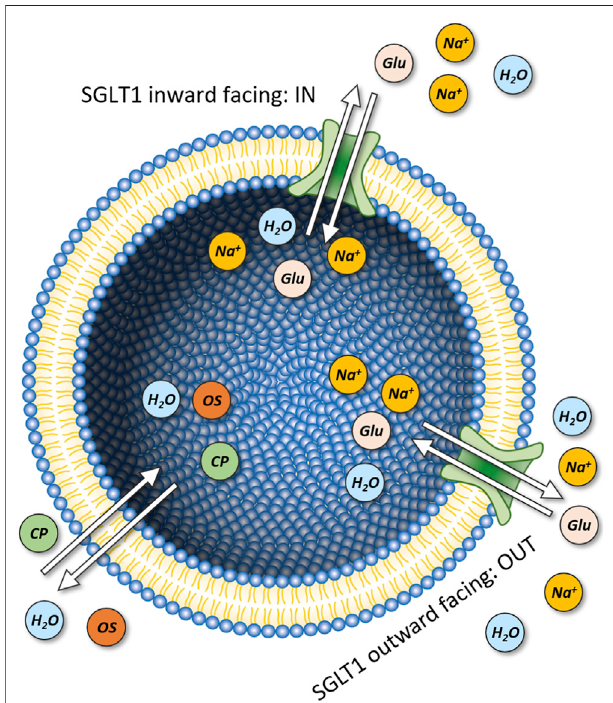
FIGURE 9 | Vesicles containing SGLT1. Model of a unilamellar vesicle with SGLT1 incorporated in two different orientations. The inward- and outwardfacingcon fi gurationsorientedtowardstheintraandextraluminalside are denoted asINand OUT, respectively. In each transportcycle SGLT1 transports 2 Na + ions and one glucose molecule. The model takes into account passive permeation of osmotically active solutes (OS) (i.e., sucrose, glucose, and NMDG 0 ) and charged particles (CP) (i.e., Na + , K + , NMDG + , Cl − , and protons) as well as passive fl ux of water.